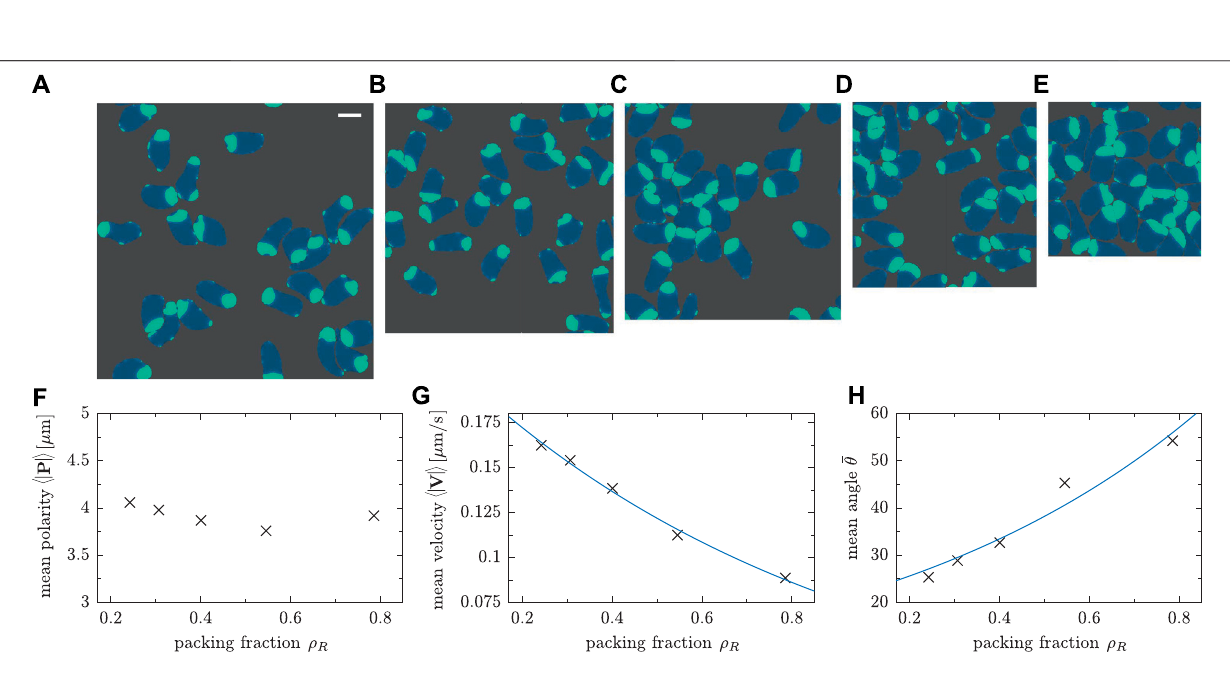
Frontiers in Physics |